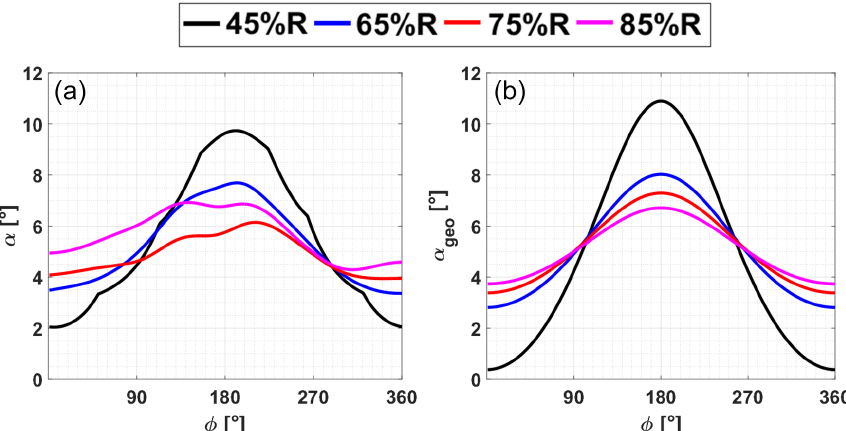
Figure 16. AoA results for yaw angle ψ = − 30 ◦ and pitch angle θ = 0 ◦ . Pressure taps and three-hole-probe approaches (a) . Analytical calculations (b)